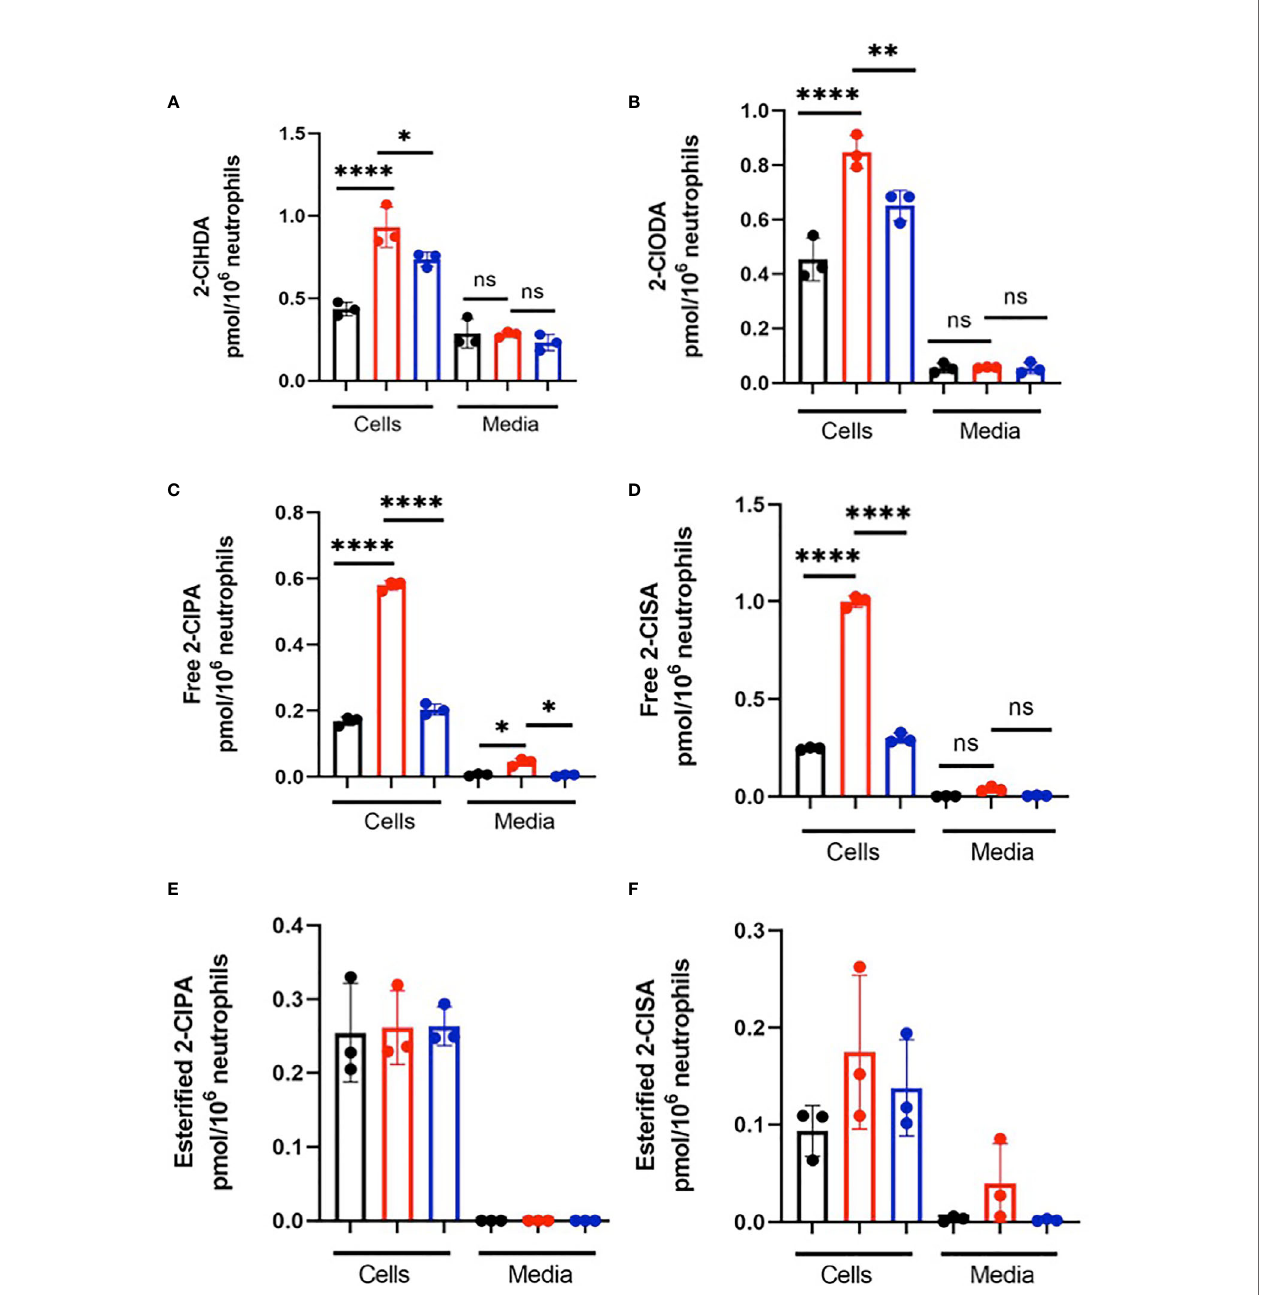
FIGURE 2 | Chlorolipids are cell-associated in neutrophils cocultured with E. coli. 2x10 6 /ml neutrophils were incubated with either no bacteria (control, black), or, CFT073 (red) or JM109 (blue) strains of E. coli at a neutrophil: E. coli ratio of 1:10 for 30 min at 37°C. Cells were pelleted, and 2-ClFALD molecular species (A , B) and 2-ClFA molecular species (C – F) were quanti fi ed as described in “ Material and Methods ” . 2-ClHDA, 2-ClODA, 2-ClPA, and 2-ClSA are 2-chlorohexadecanal, 2-chlorooctadecanal, 2-chloropalmitic acid and 2-chlorostearic acid, respectively. Multiple comparisons were performed using one-way ANOVA with Tukey ’ s multiple comparison test. Data represent n=3, error bars for ± SD, p-value: ****< 0.0001; **< 0.01; * < 0.05. ns indicates not signi fi